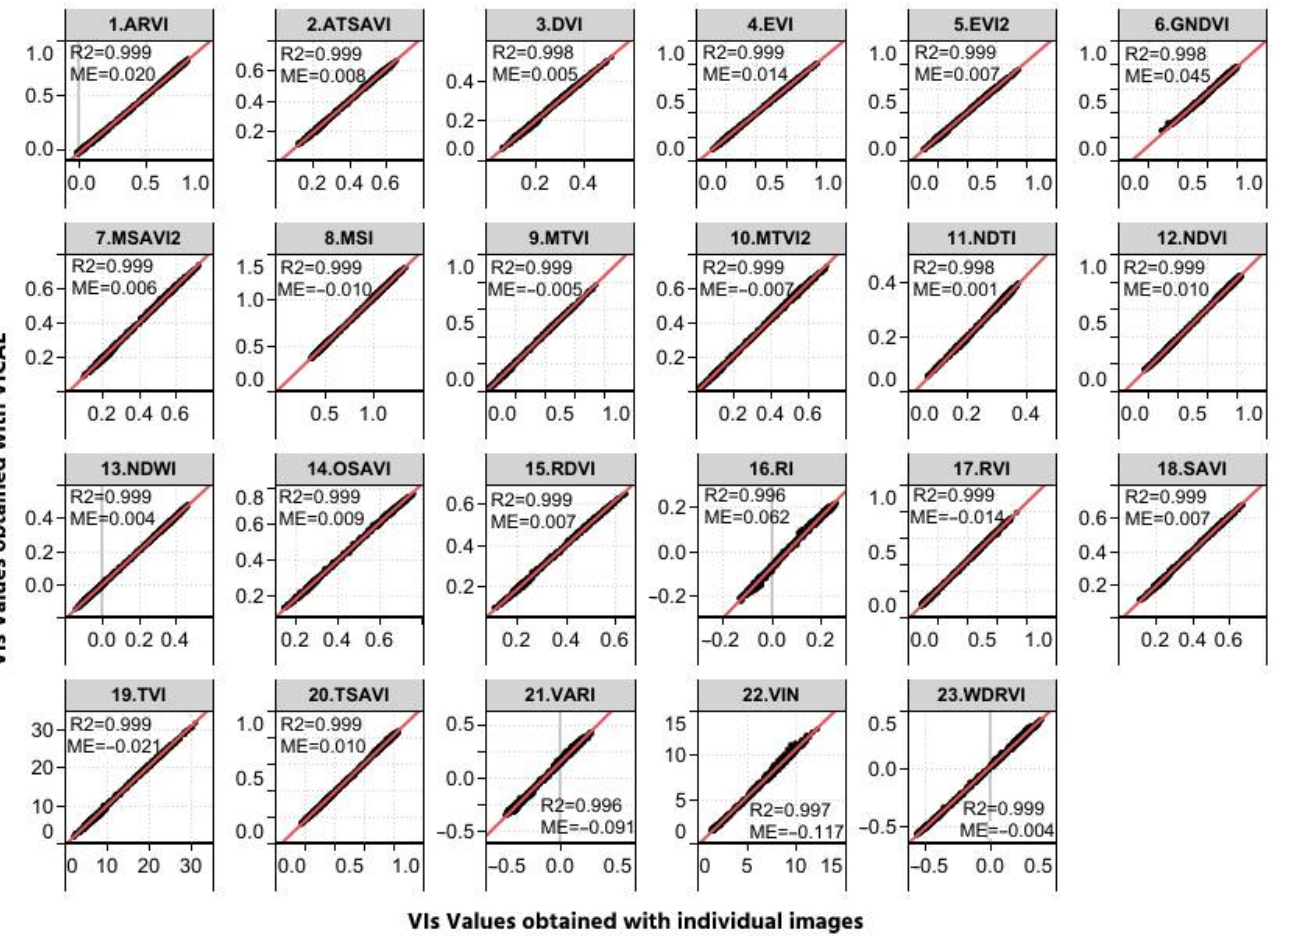
Figure 7. R 2 and ME values of the VIs obtained by VICAL and those obtained through the individual processing of Landsat-8 images. Each point represents the average value of the VI in a parcel.